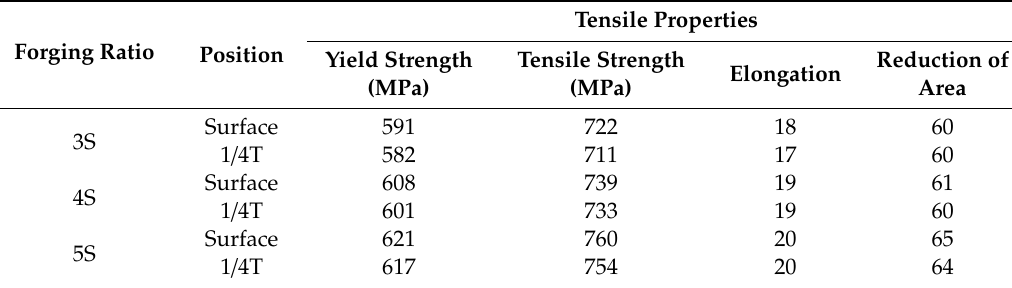
Table 8. Mechanical properties of the forged bars at various forging ratios Tensile Properties Forging Ratio Position Reduction of Yield Strength Tensile Strength Elongation Area (MPa) (MPa) Surface 591 3S Surface